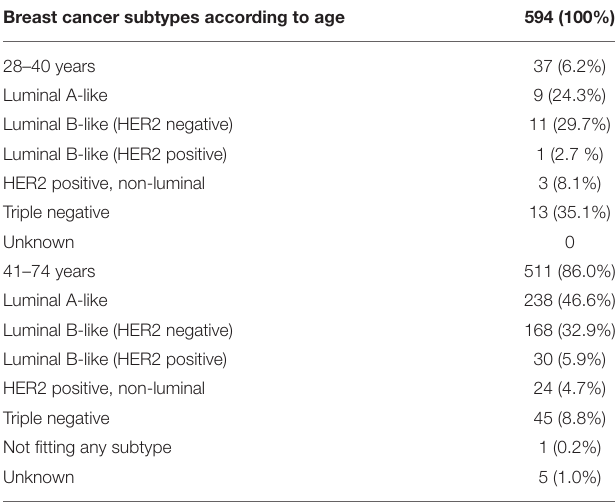
TABLE 4 | Subtype distribution for each age group. Breast cancer subtypes according to